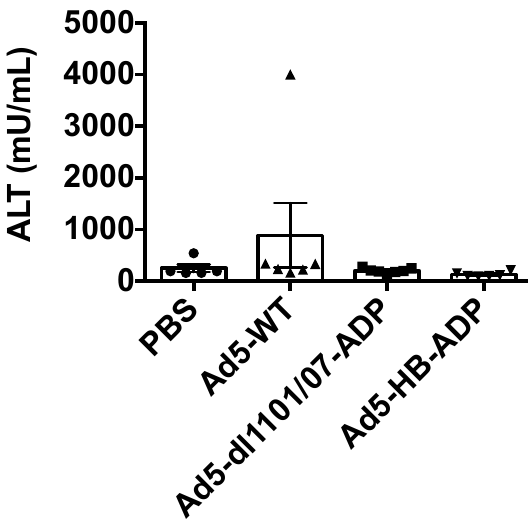
Figure 4. Liver damage after intravenous injection. Syrian hamsters were injected with 5 × 10 11 vp of the indicated adenoviruses and liver damage was assessed by measurement alanine amino transferase (ALT) release in the blood three days after injection ( n = 5–7 animals).